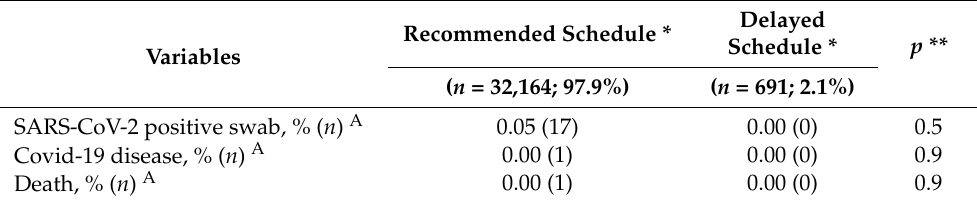
Table 4. Comparison between those who received the second dose of vaccine within the recom- mended number of days, and those who had a delayed